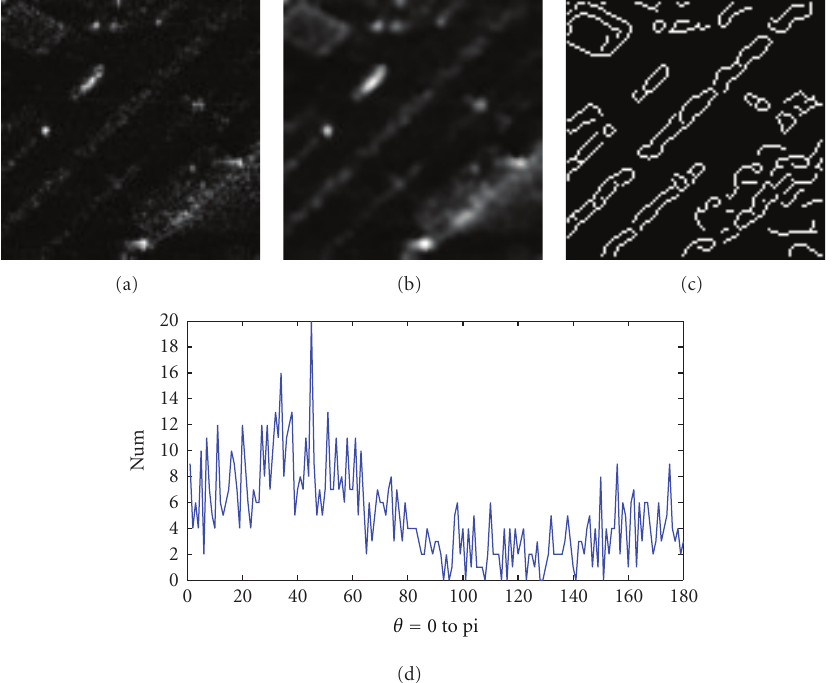
Figure 6: Orientation estimation 2. (a) Cropped SAR image. (b) Frost filter. (c) Canny edge detection. (d) Edge orientation